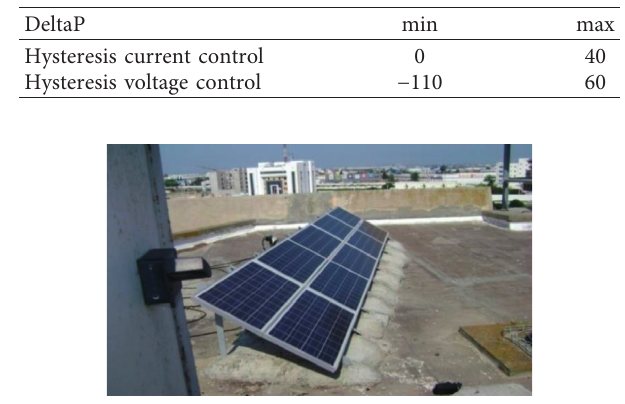
Figure 25: PV generator installed on ERCO-INSAT.